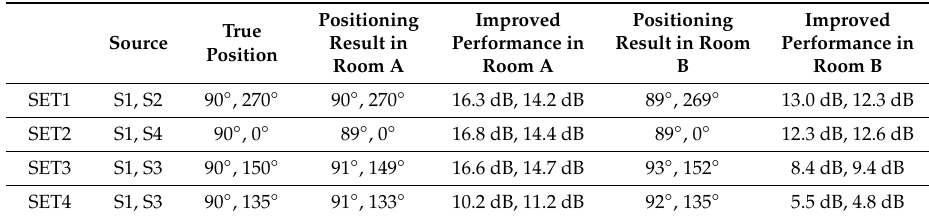
Figure 7. SIR improvement with separation under dual sources in Room B. ( a – d ) correspond to SET1-SET4, respectively. Table 2. Results by proposed method under dual sources in Room A and Room B.